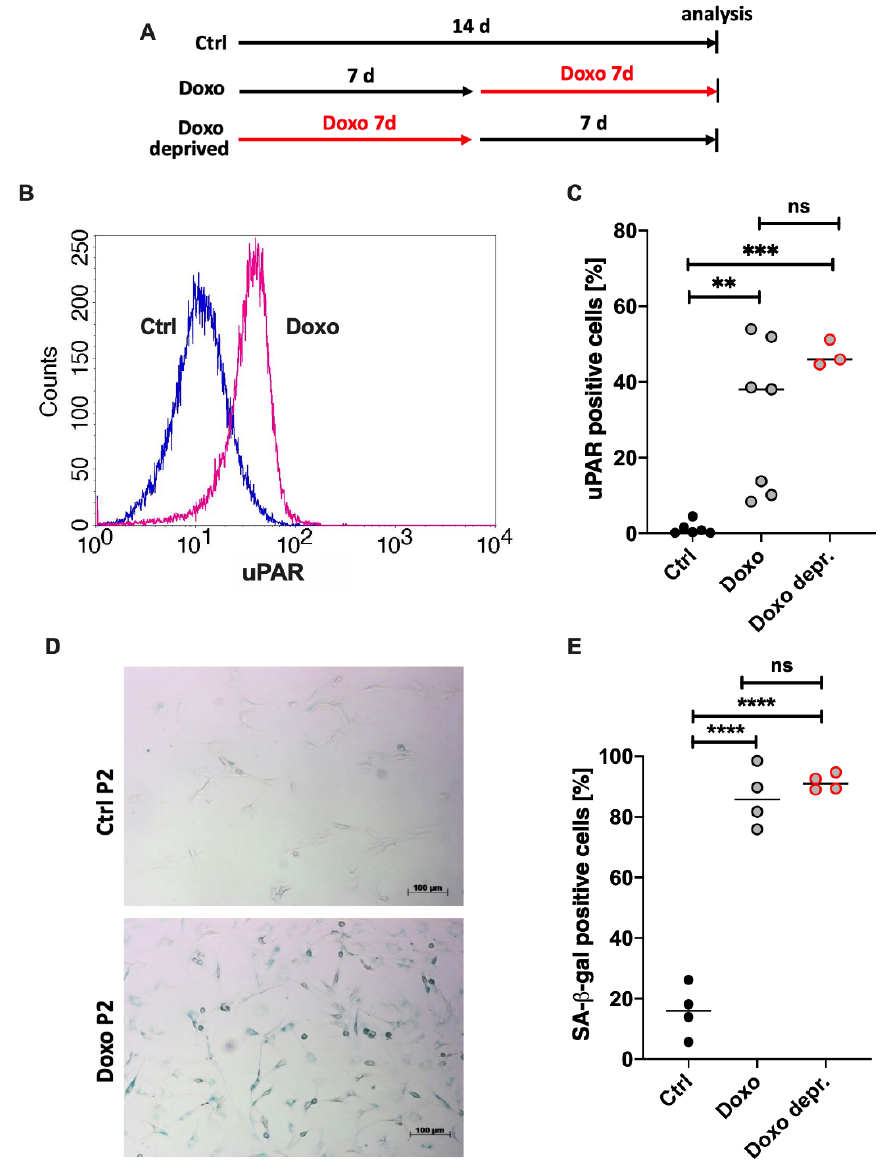
Figure 5. Impact of Doxo stimulation on uPAR expression and SA- β -gal activity in hAC. ( A ) Outline of the experimental setup. ( B ) Histogram of cytometric analysis of uPAR (CD87) on hACs unstimulated (blue) or stimulated with 0.1 µ M Doxo for 7 d (pink). ( C ) Corresponding statistics of cytometric analysis of uPAR w/or w/o Doxo stimulation. ( D ) Exemplary phase contrast microscopy images of SA- β -gal staining in hACs (w/or w/o Doxo stimulation). ( E ) Corresponding quantification of SA- β -gal positive cells. Data are presented as scatter plot with median. Significant differences between groups are depicted as: **** p ≤ 0.0001; *** p ≤ 0.001; ** p ≤ 0.01. Statistical analysis: ( C , E ) one-way ANOVA, Sidak’s multiple comparisons test. Ctrl = control (unstimulated cells), ns = not significant.